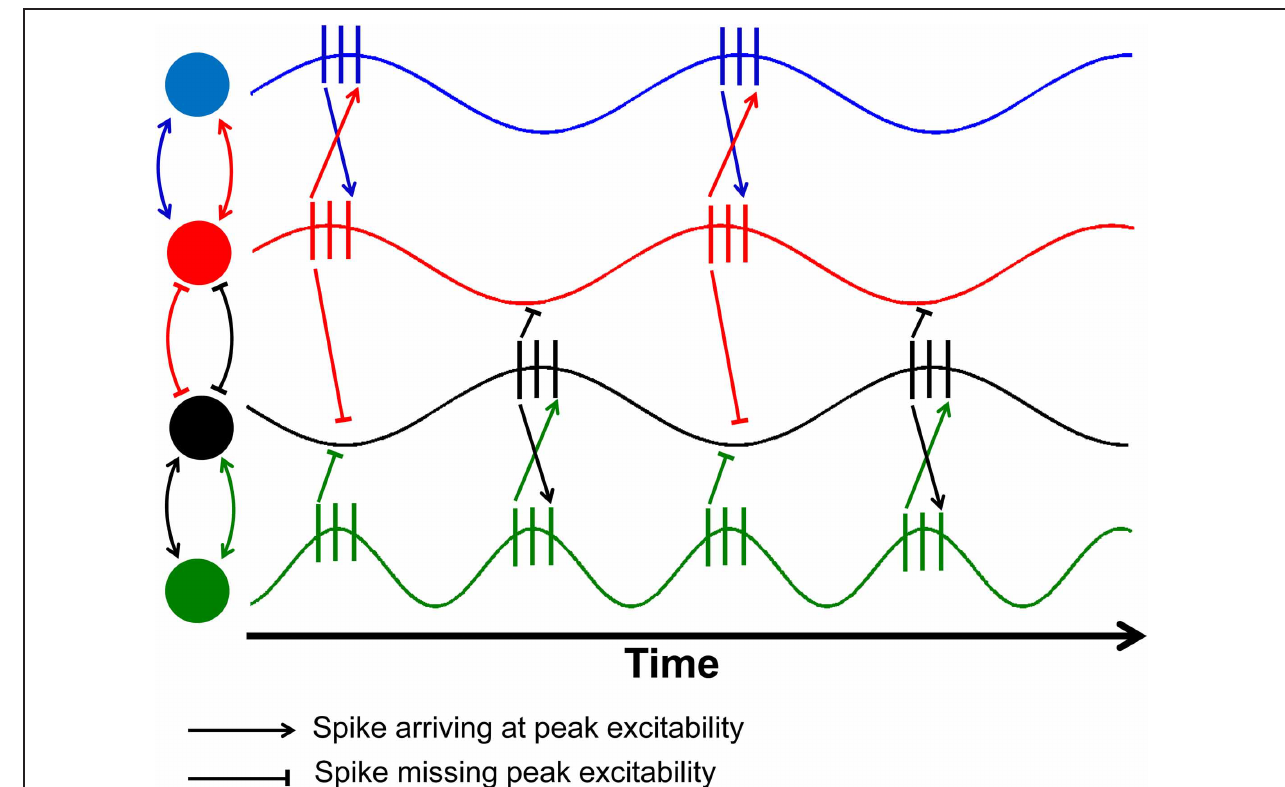
circles. The relationship between the red and black nodes have been delayed so much that the spikes from one neuron arrive at the valley in excitability of the other. The green neuron has double the firing rate of the black neuron, allowing half of the spikes to arrive at peak excitability.